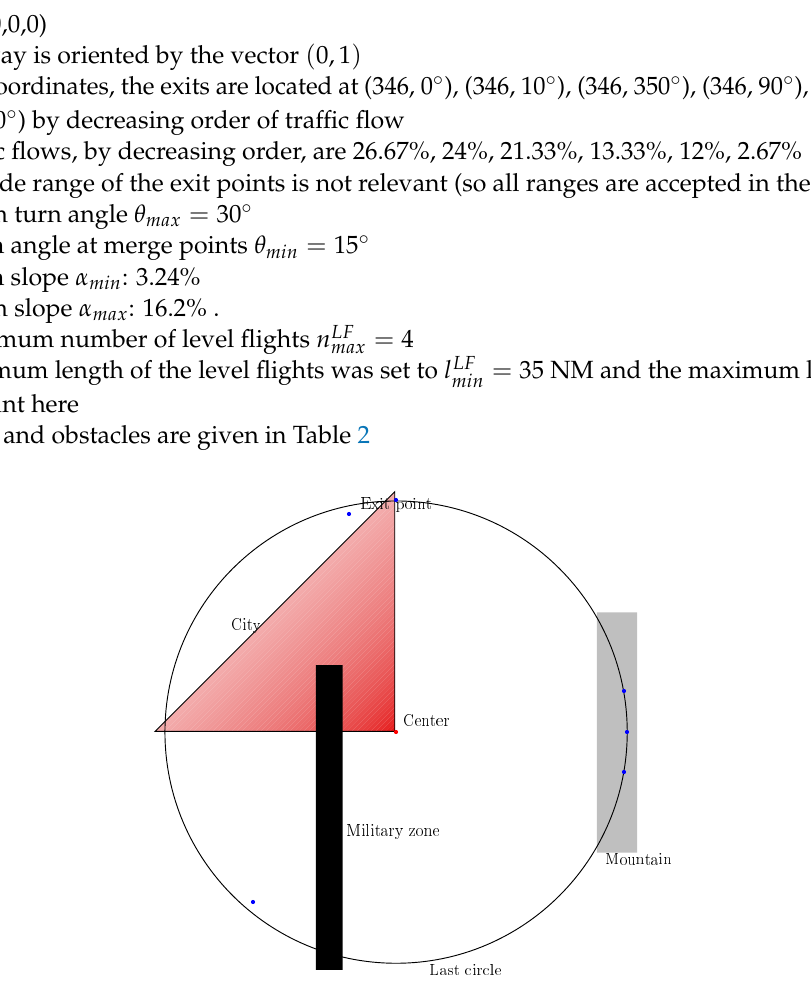
Figure 10. The layout used to test the